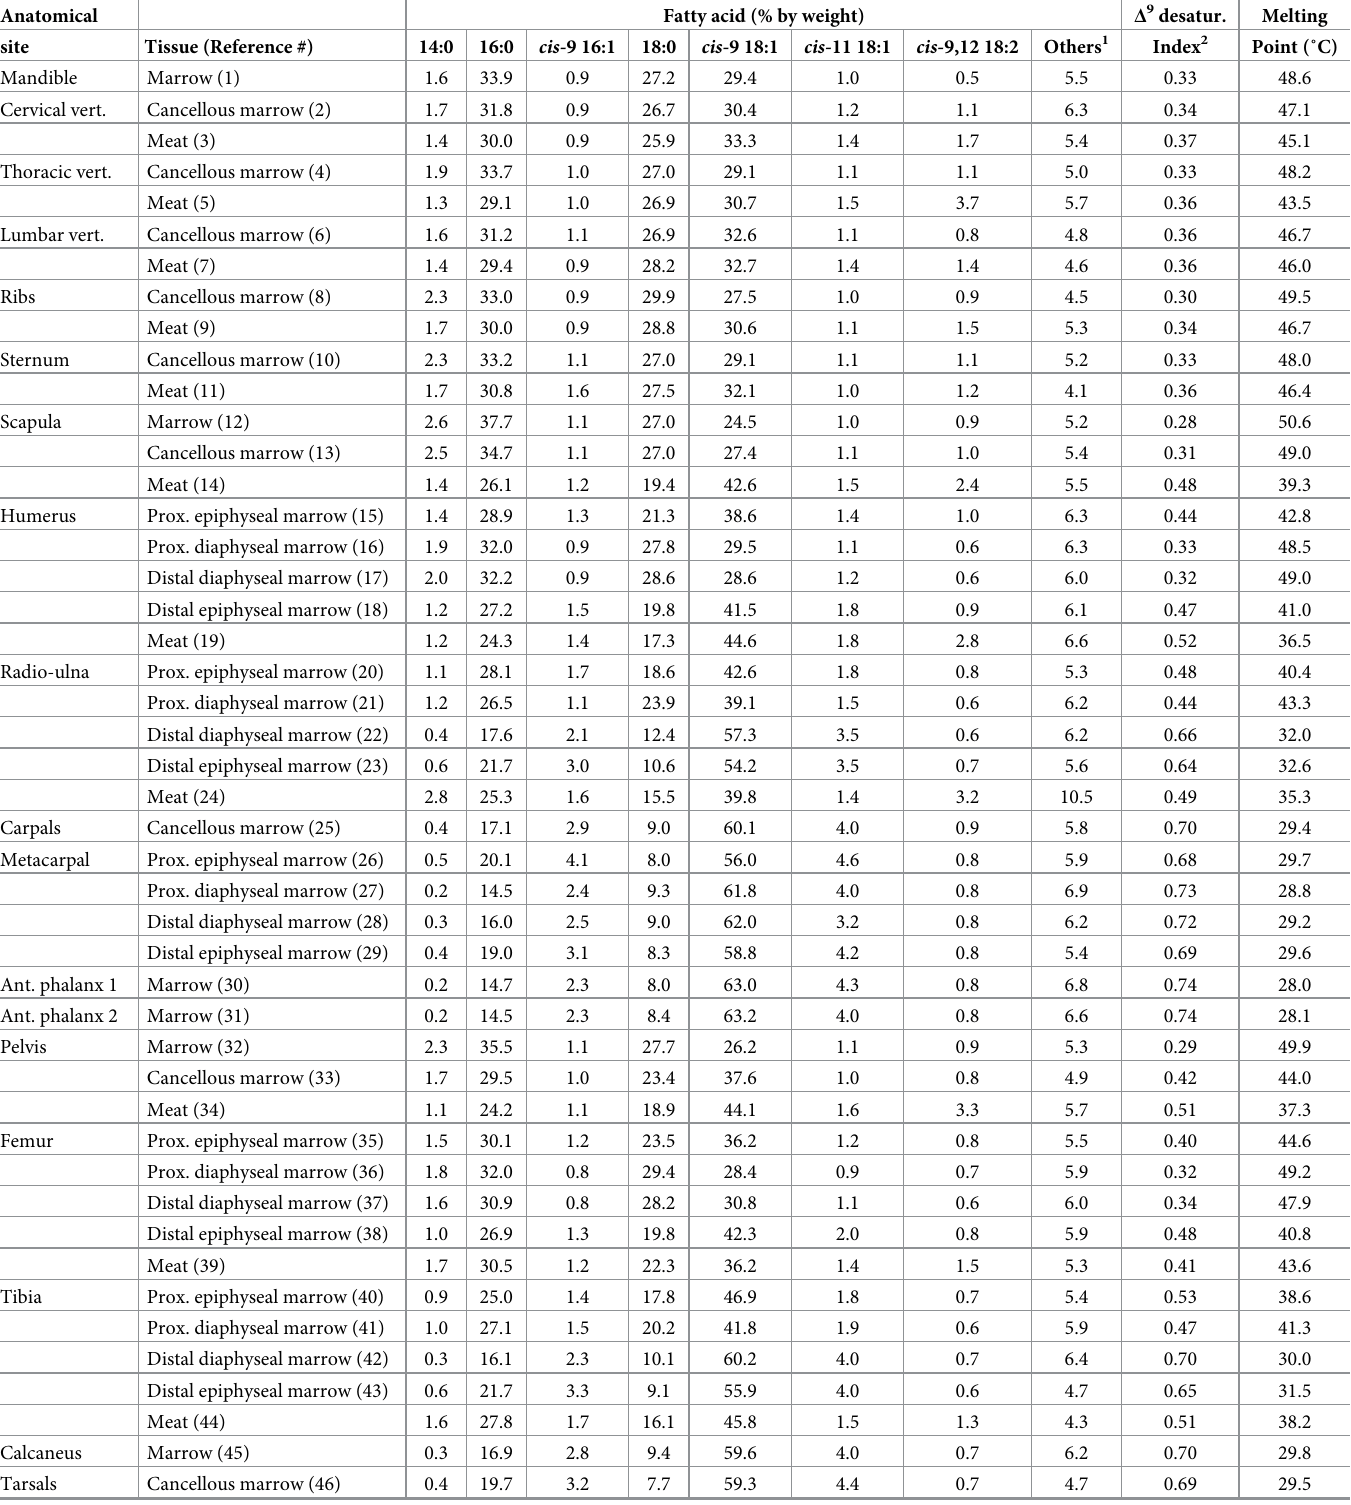
Table 2. Fatty acid profile and calculated melting point of lipid extracted from varying body tissues in caribou. The values are averages for the two animals. Anatomical Fatty acid (% by weight) Δ 9 desatur. Melting site Tissue (Reference #) Mandible